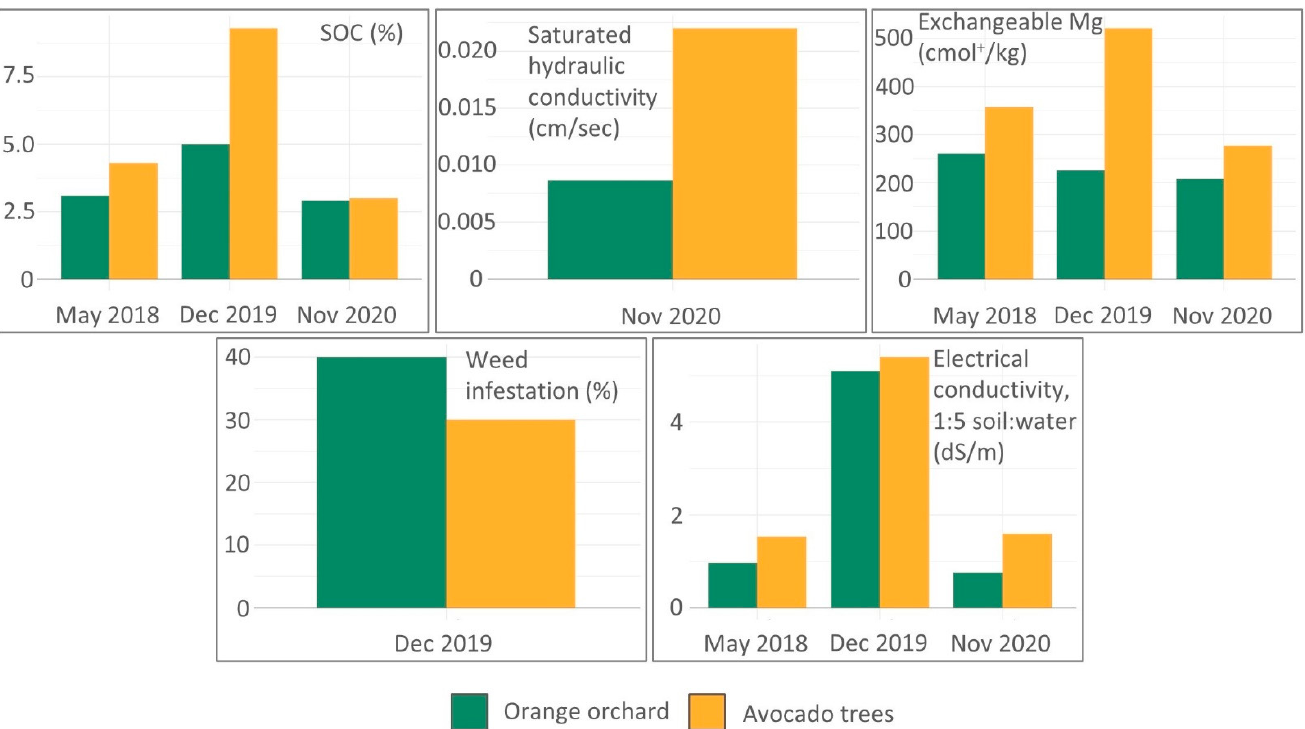
Figure 7. Soil properties in orange and avocado plot at the fruit orchard field during the 3-year monitoring.